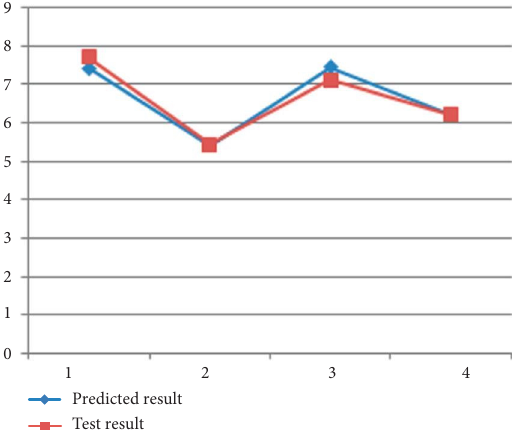
Figure 26: Warpage deformation fit comparison.